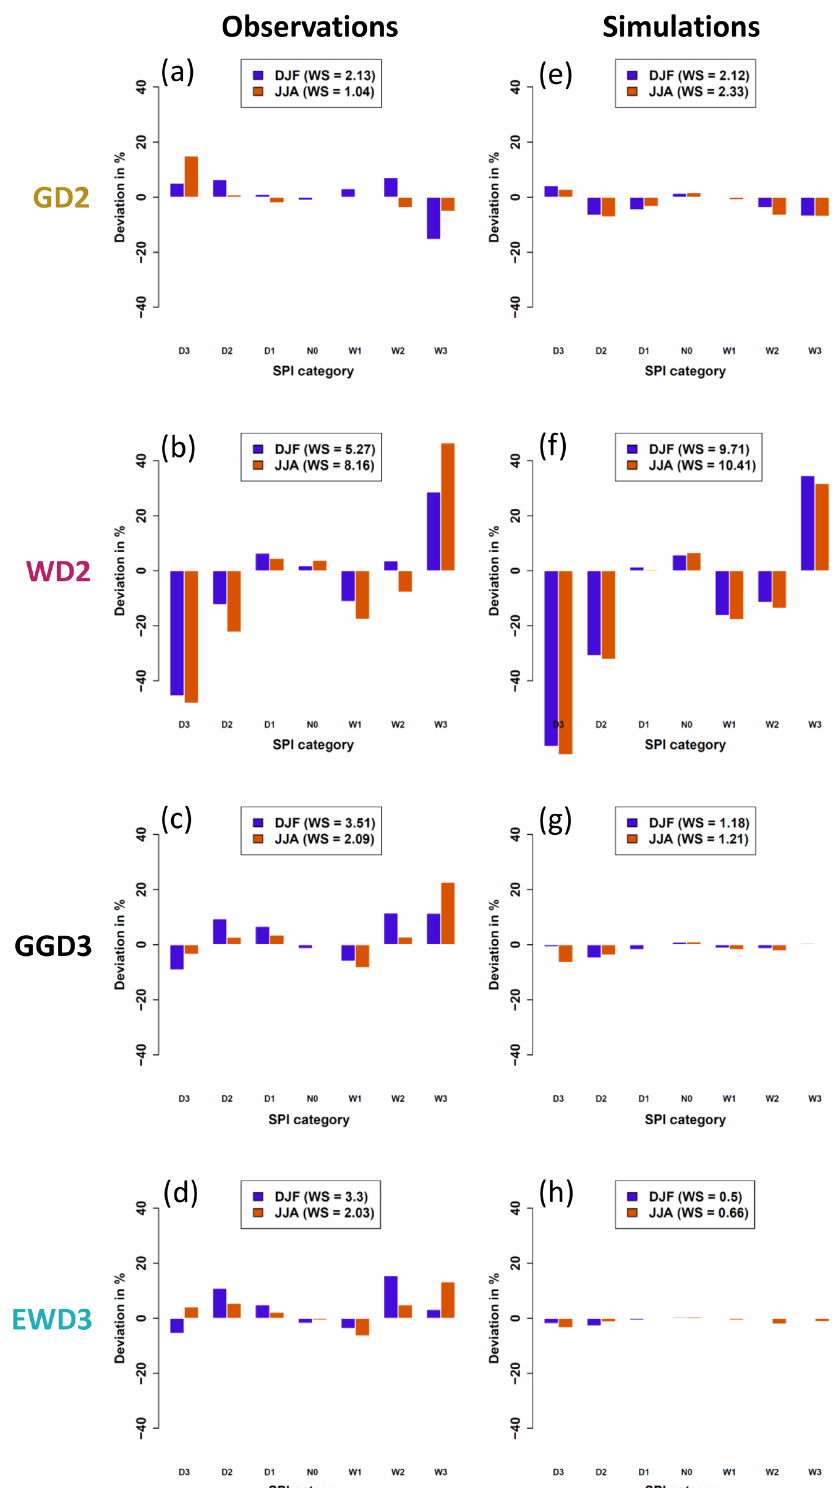
Figure 4. Deviations from N 0 , 1 over the entire globe for observed (a–d) and modeled (e–h) SPI time series. SPI time series are derived by using the simple two-parameter gamma distribution (GD2; a, e ), the simple two-parameter Weibull distribution (WD2; b, f ), the three- parameter generalized gamma distribution (GGD3; c, g ), and the three-parameter exponentiated Weibull distribution (EWD3; d, h ). The legends depict weighted (by their respective theoretical occurrence probability) sums (WSs) of deviations from N 0 , 1 over all SPI categories. Irrespective of the candidate PDF, deviations from N 0 , 1 are smallest for the center of SPI’s distribution (N0) and largest for its